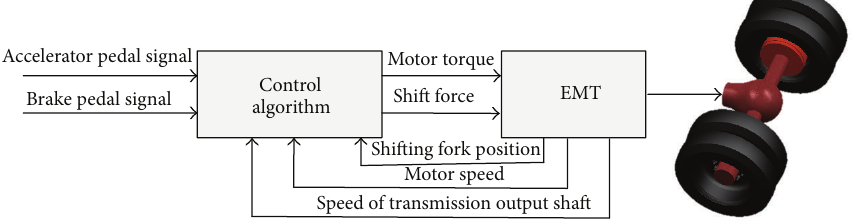
Figure 10: The diagram of the shifting process control model.